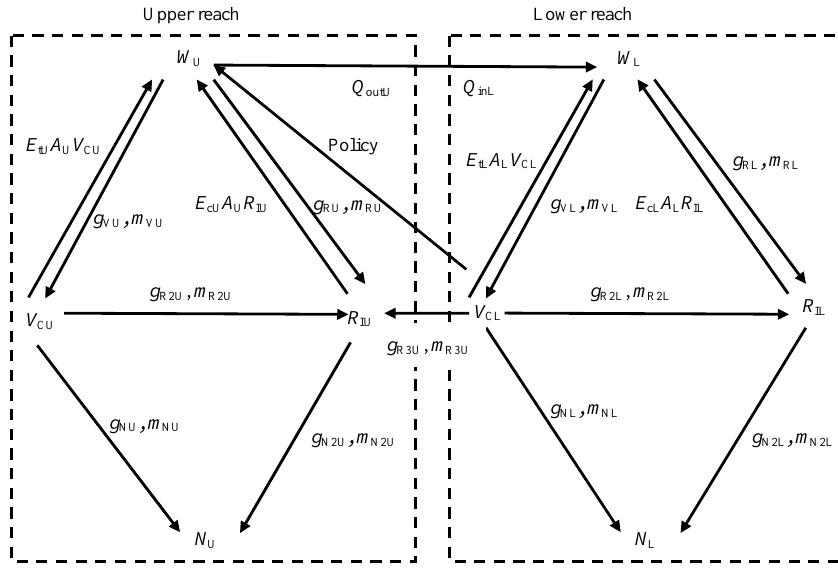
Figure 4. Feedbacks in the socio-hydrological system of the Tarim